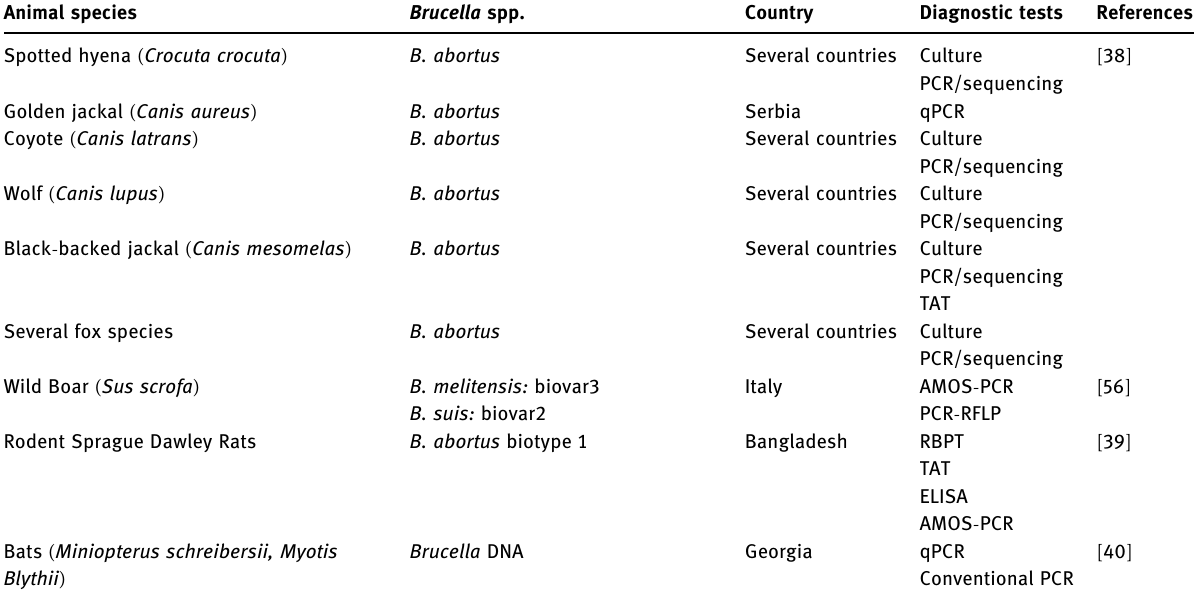
Table 2: Major wild animals species which may be in promiscuity with dromedary camels, isolated Brucella spp., used diagnostic tests, and concerned countries Animal